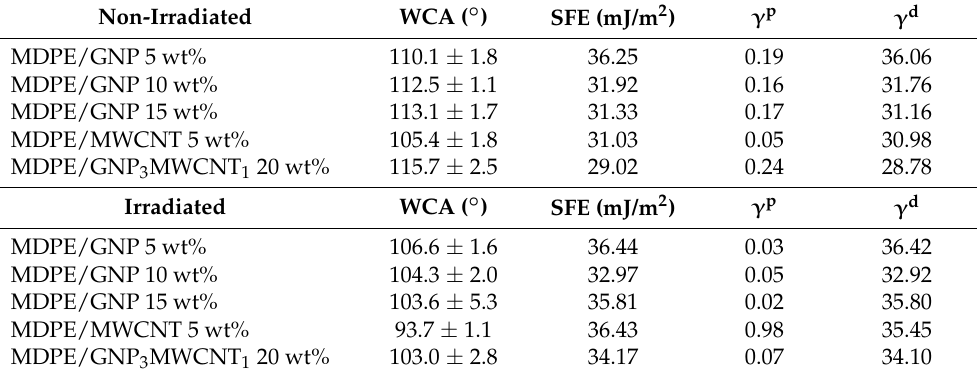
Table 6. Water contact angles (WCA) and surface free energies (SFE) with dispersive ( γ d ) and polar ( γ p ) components of MDPE/GNP 5 wt%, MDPE/GNP 10 wt%, MDPE/GNP 15 wt%, PE/MWCNT 5 wt% and MDPE/GNP 3 MWCNT 1 20 wt% before and after proton irradiation.